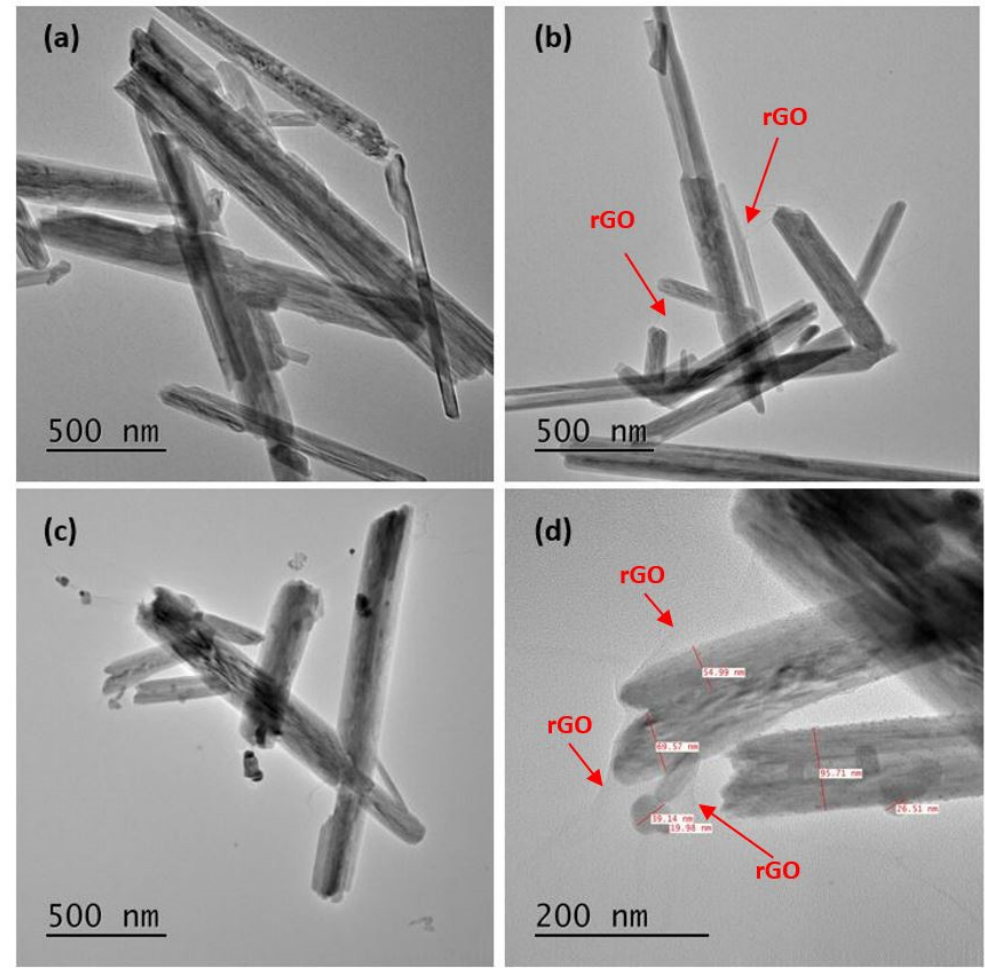
Figure 6. TEM image of ( a ) MnO 2 rod, ( b ) rGO@MnO 2 , ( c ) Ag-rGO@MnO 2 nanocomposite at magnification 40k×, and ( d ) TEM image of Ag-rGO@MnO 2 at high at magnification 200k×.